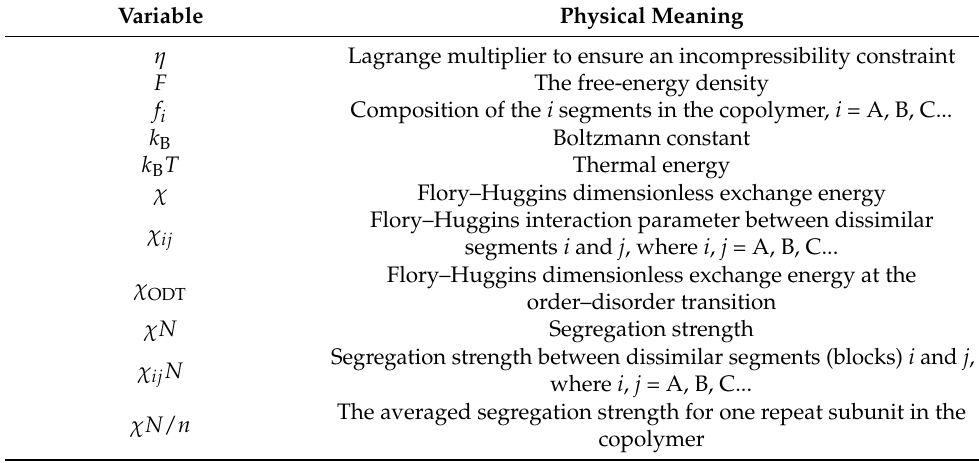
Table A2. The quantities and all variables used in this paper and their physical